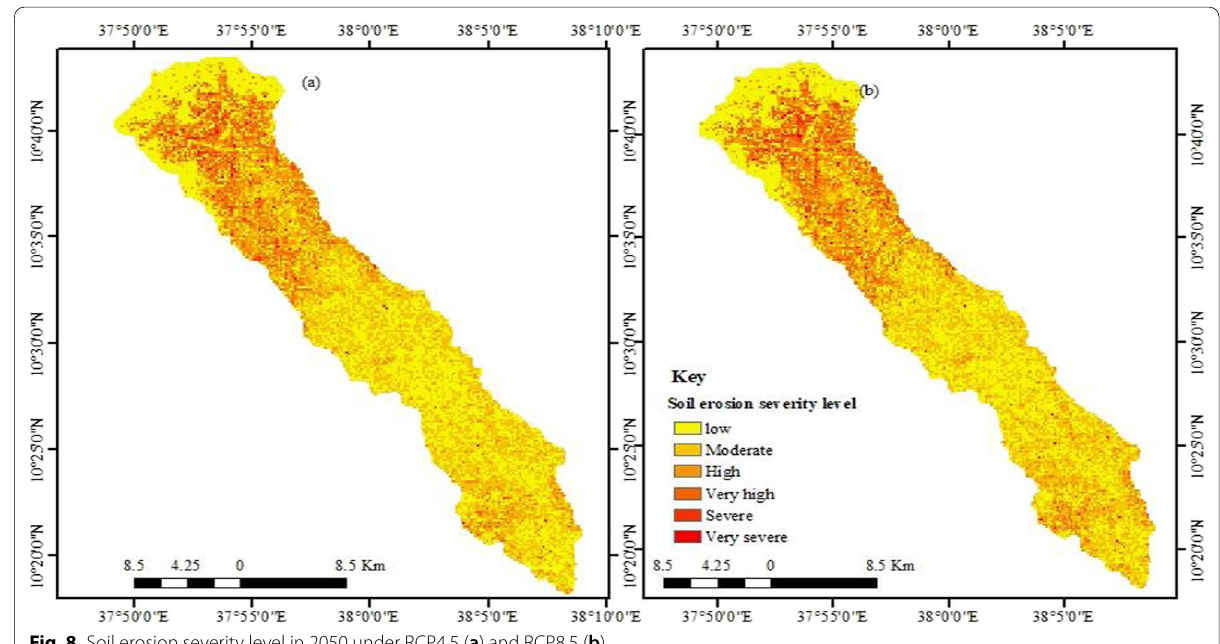
Fig. 8 Soil erosion severity level in 2050 under RCP4.5 ( a ) and RCP8.5 ( b